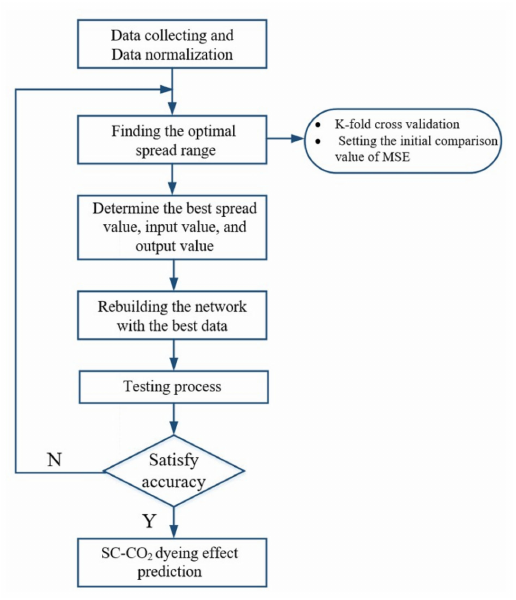
Figure 2. Preparation steps of the GRNN